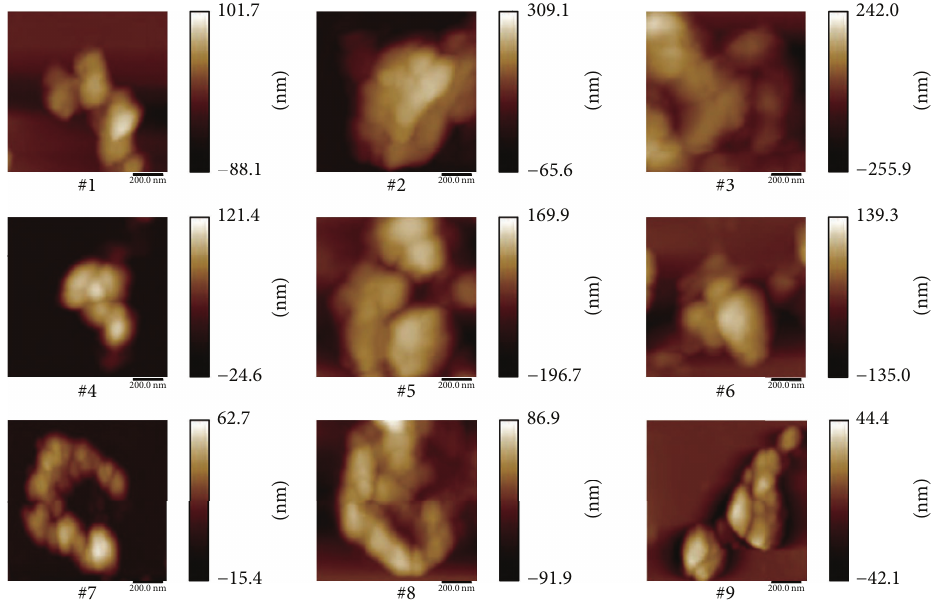
Figure 2: Nanometer size morphologies of nine Zuotai samples by atomic force microscopy (AFM). Note: #1 is the sample of Aba Prefecture Tibetan Medicine Hospital; #2 is the sample of Gan’na Prefecture Tibetan Medicine Hospital; #3, #4, and #5 are the samples of the Company of Tibetan Medicine of Tibetan Traditional Medical College; #6, #7, and #8 are the samples of Qinghai Province Tibetan Medicine Hospital; #9 is the sample of the Company of Tibetan Medicine of Tibetan Autonomous Region.